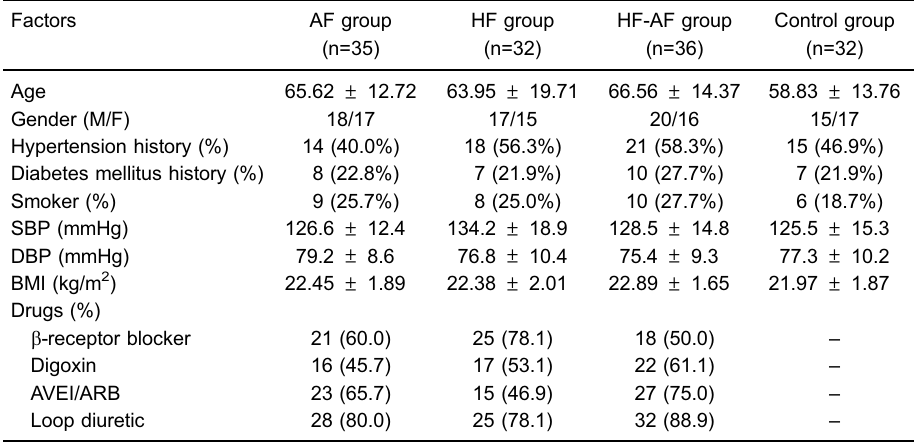
Table 1. Comparisons of clinical data among the four